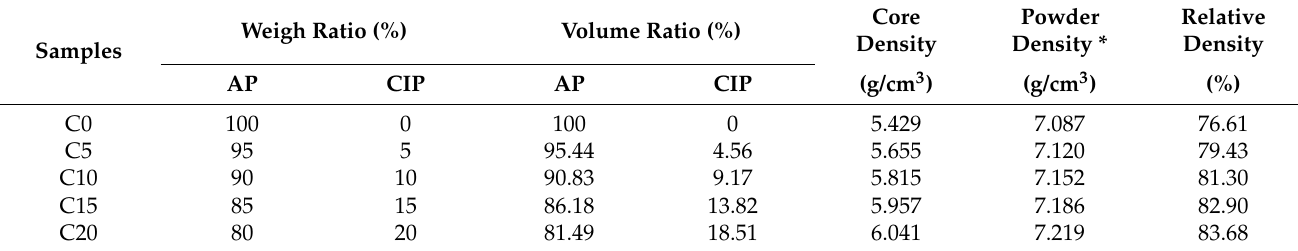
Table 1. Mixing ratio of amorphous and carbonyl-iron power for hybrid SMCs and corresponding density.